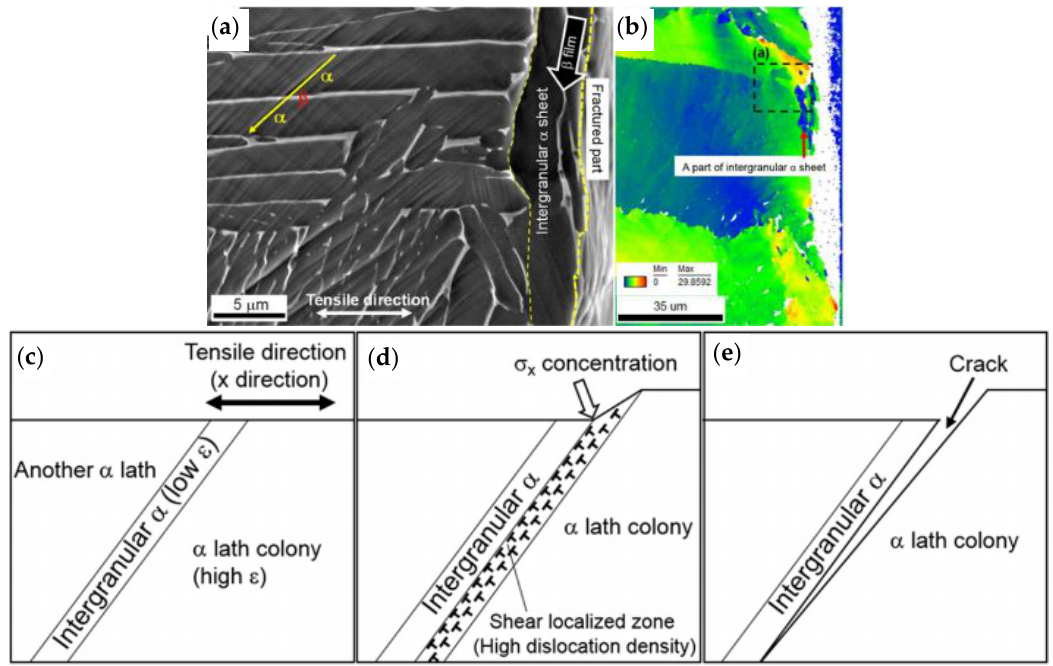
Figure 14. ( a ) Slip traces in magnified SE image of lamellar structure in Ti-6Al-4V; ( b ) KAM map near intergranular α sheet; ( c ) schematic of original microstructure; ( d ) schematic of dislocation pile up at intergranular; ( e ) schematic of the crack nucleation [103].